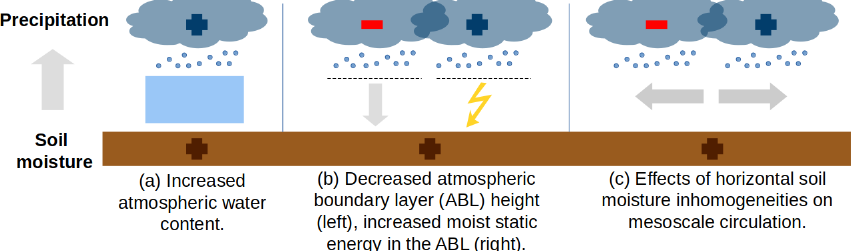
Figure 2. Concurring pathways of soil-moisture–precipitation coupling. An increase in soil moisture can increase latent heat flux and decrease sensible heat flux at the land surface (Seneviratne et al., 2010). This can increase precipitation via an increase in atmospheric water content ( a ; Eltahir, 1998). At the same time, it can increase or decrease precipitation via boundary layer dynamics ( b ; Findell and Eltahir, 2003a, b; Gentine et al., 2013) or via effects of spatial heterogeneity in latent and sensible heat fluxes on mesoscale circulations ( c ; Eltahir, 1998; Adler et al., 2011; Taylor et al., 2011; Taylor, 2015).